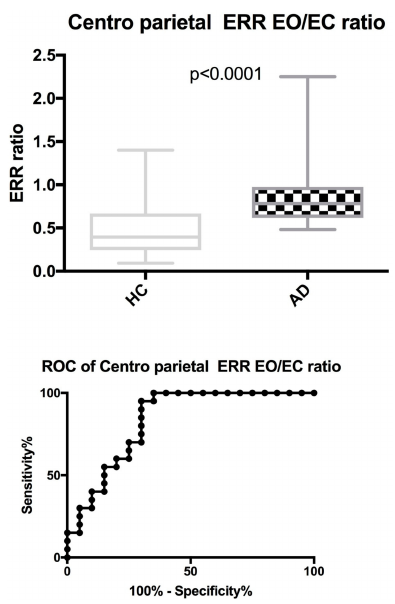
Figure 4. QEEG EO/EC bi-centroparietal synchronization ratio, group comparison between AD and HC (including ROC). This figure depicts the EO/EC bi-centroparietal synchronization ratios for HC (Healthy Controls) and AD (Alzheimer disease). The ROC curve represents a cut-off point at 0.51 for all participants producing a sensitivity of 95% and specificity of 75%.